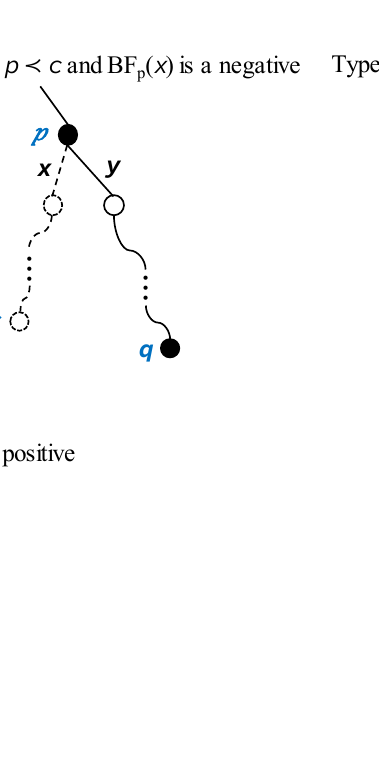
Figure 6. The organization of overall name lookup.